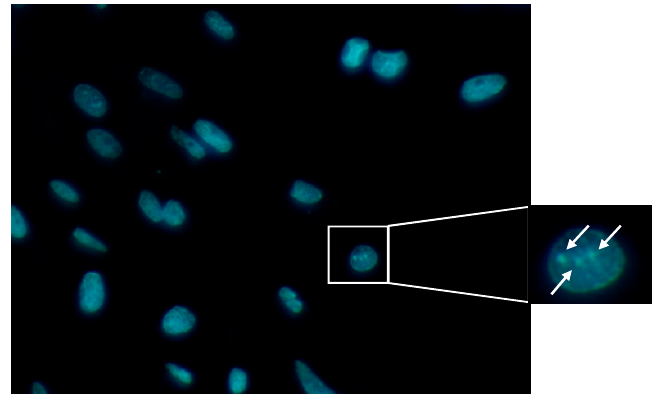
Figure 11. Example of an image obtained through Hoechst assay. In the picture is pointed the chromatin condensation.